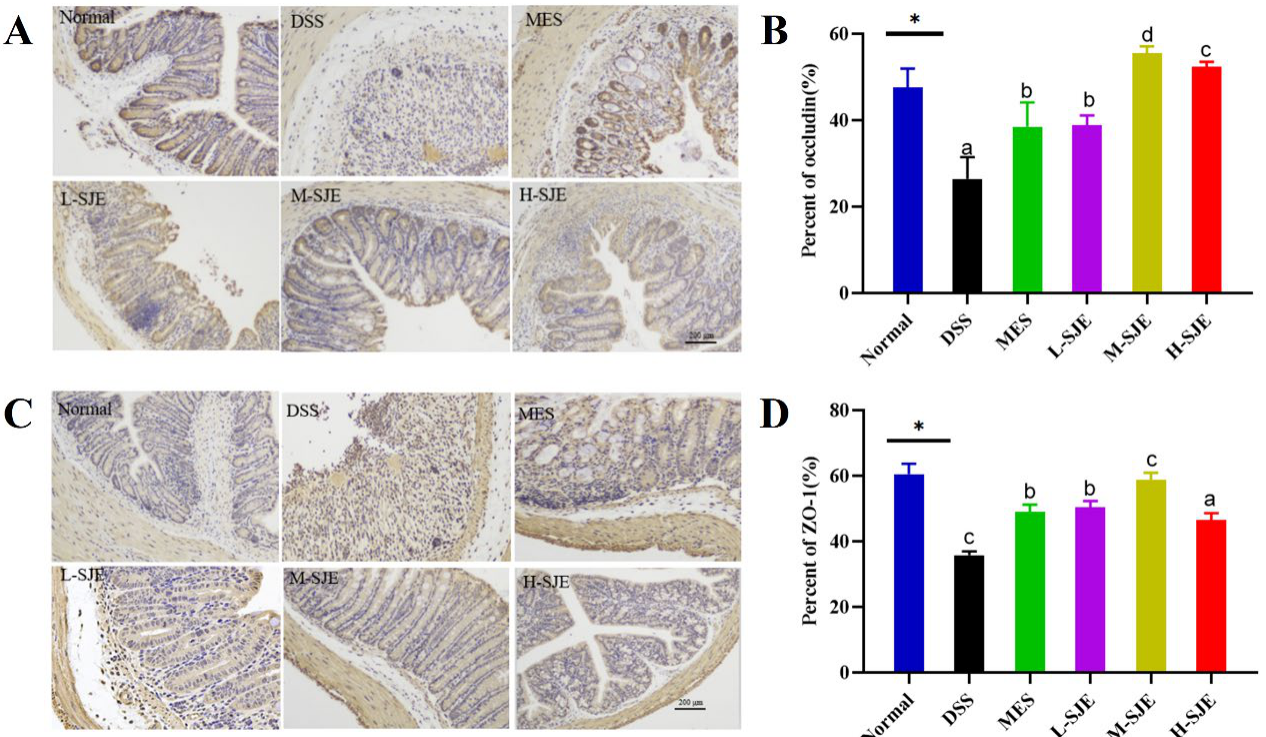
Figure 3. Effects of SJE on gut barrier integrity. Representative pictures of occludin and ZO-1 with amplification (100 ×). Scale bars, 200 µm. ( A – D ) IHC staining and quantitative analysis of occluding and ZO-1. * p < 0.05 means statistically significant. Different superscript letters (a–d) in the same graph indicate significant differences between groups ( p < 0.05).